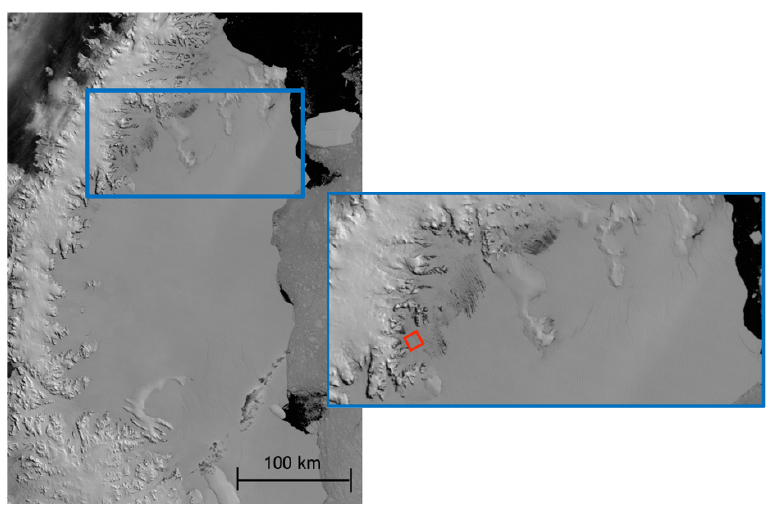
Figure 1. NASA MODIS imagery of the Larsen C Ice Shelf (Scambos et al., 2001). The image was captured on 7 January 2007 at 13:15. The presence of melt lakes is shown through the zoomed image of the northern part of Larsen C, where the red outlined area shows the location of the data used to produce Fig.